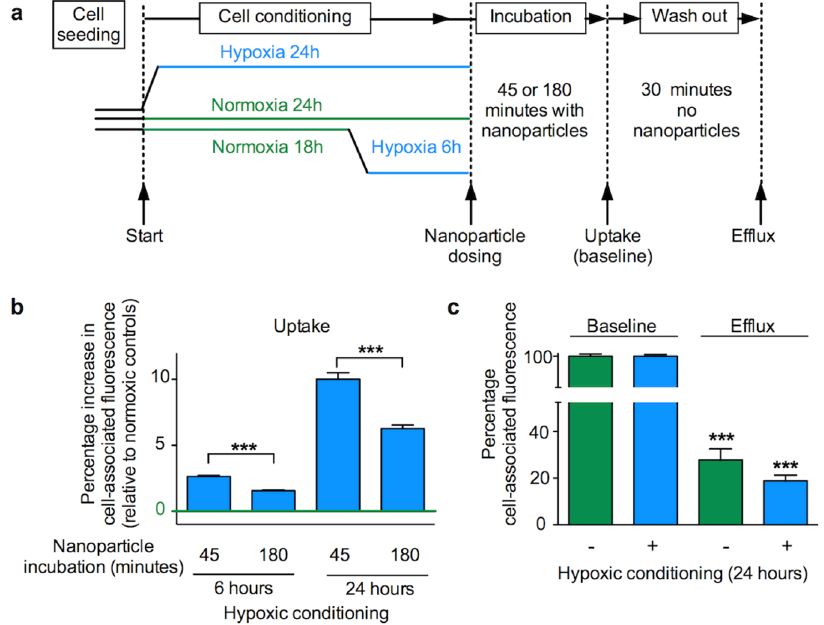
Figure 4. Impact of hypoxic preconditioning on the uptake (endocytosis) and recycling (exocytosis) of nanoparticles by human MDA-MB-231 breast cancer cells. ( a ) Diagram of the experimental approach. Cells were conditioned in hypoxia (1% O 2 ) for either 6 or 24 hours and then dosed with nanoparticles at an effective concentration of 1 × 10 10 nanoparticles/ml for either 45 or 180 minutes. For the recycling studies, cells were preconditioned for 24 hours in either hypoxia (1% O 2 ) or normoxia. Next, cells were dosed with nanoparticles at an effective concentration of 1 × 10 10 nanoparticles/ml for 45 minutes and analysed (baseline), or washed and allowed to exocytose for 30 minutes (exocytosis) ( b ) Cell uptake of fluorescent nanoparticles was assessed by measuring mean single cell-associated fluorescence by flow cytometry. ( c ) Exocytosis of fluorescent nanoparticles of normoxia or hypoxia preconditioned cells. For ( b , c ) mean single cell-associated fluorescence was measured by flow cytometry; ≥ 10,000 events; n = 15 for each dosing group and treatment period, 3 independent biological experiments ±